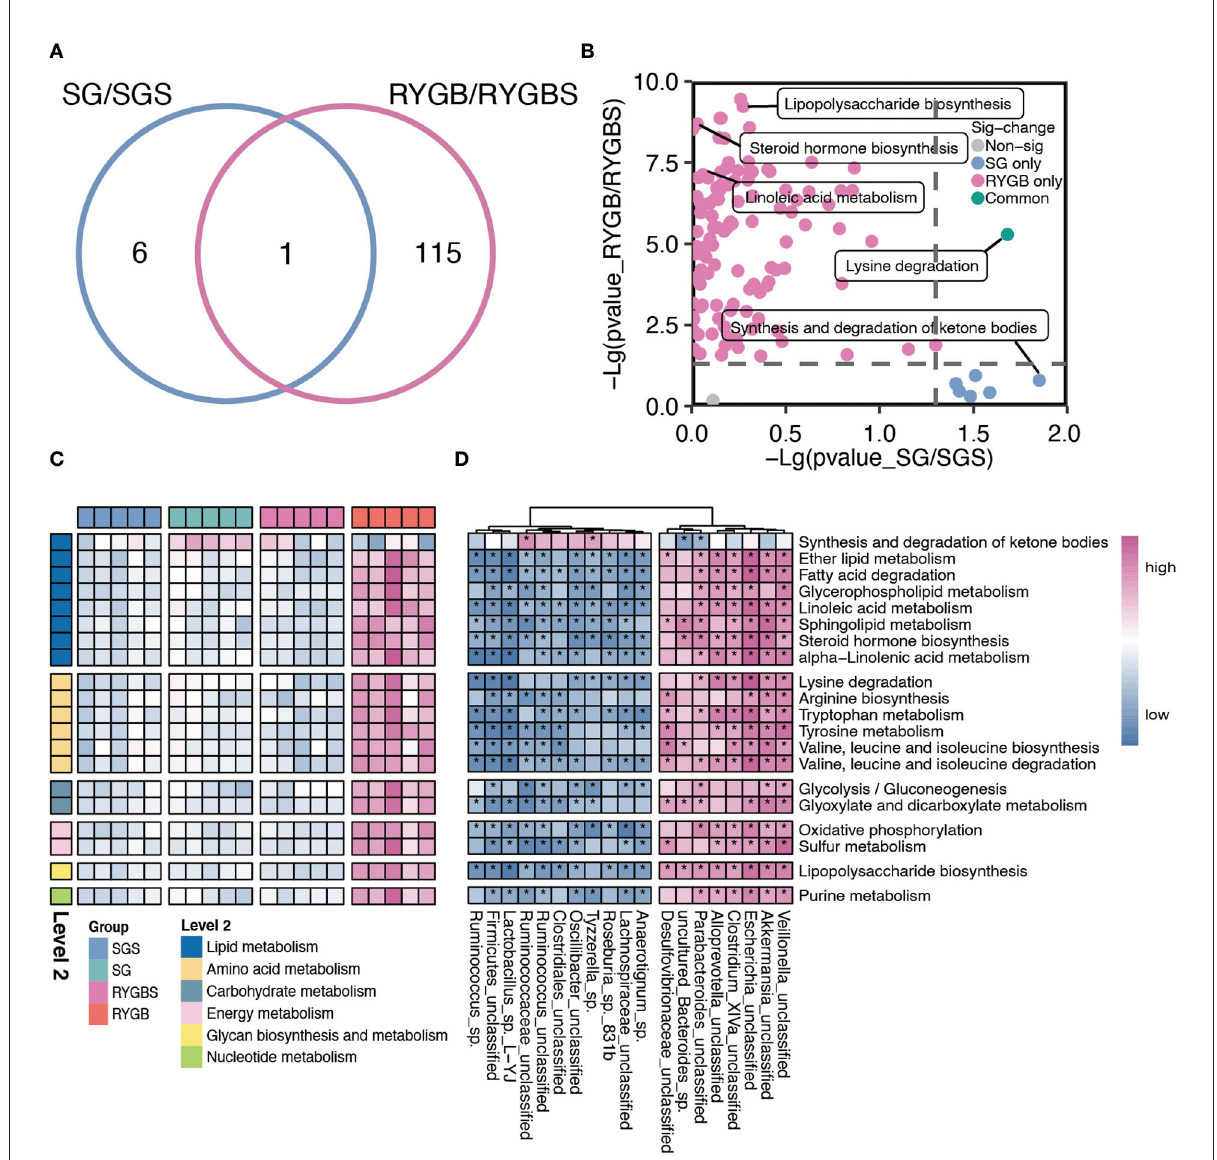
FIGURE3 Characteristic function of gut microbiota in SG and RYGB rats. (A) A Venn diagram summarizing the differential and overlapping altered microbiota function between SG and RYGB relative to sham operations, respectively. (B) The clear but distinct difference between SG and RYGB compared to sham operations, respectively. (C) The predicted function of bacteria in the indicated groups. (D) The connection between the predicated function of intestinal microbiota and altered gut microbiota. Red denotes positive correlations. Blue denotes negative correlations. * P <